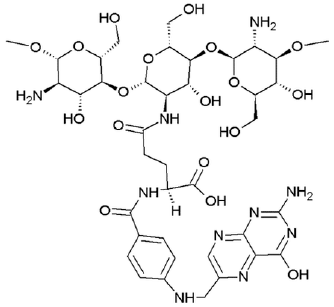
Figure 6. Folate-conjugated chitosan.